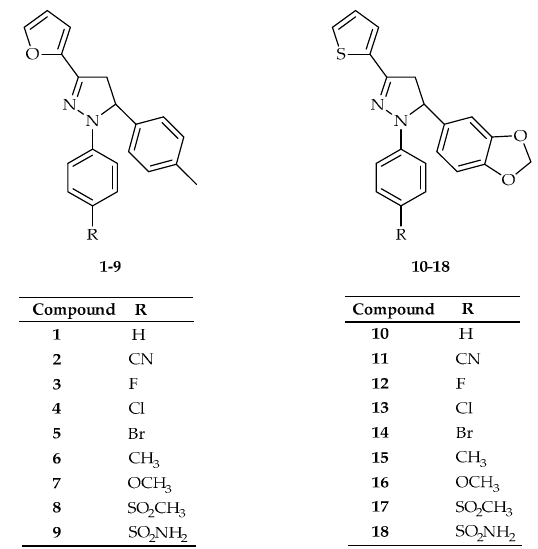
Figure 1. The structures of pyrazoline-based compounds 1–18